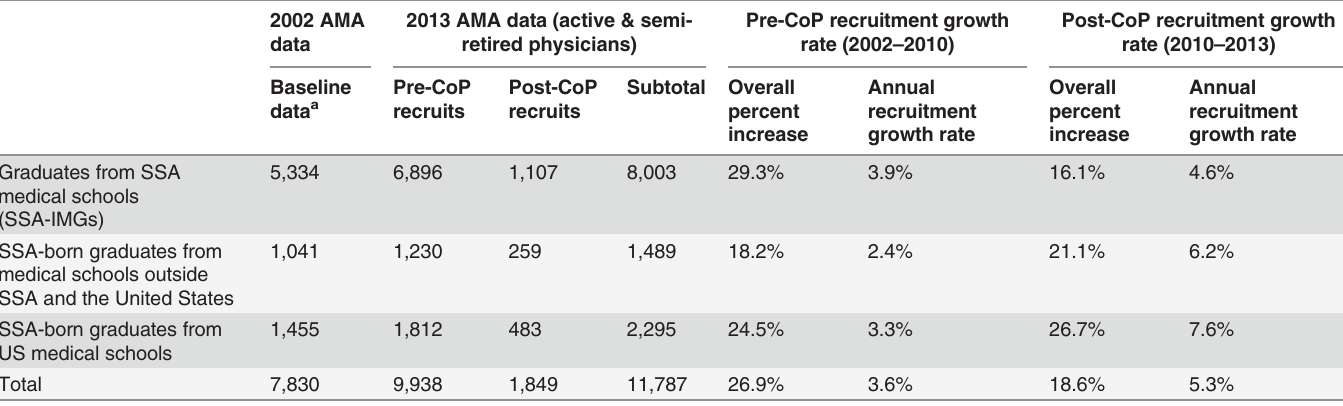
Table 3. Sub-Saharan African (SSA) immigrant physicians appearing in the American Medical Association (AMA) Physician Masterfile before and after the launch of the WHO Global Code on the International Recruitment of Health Personnel